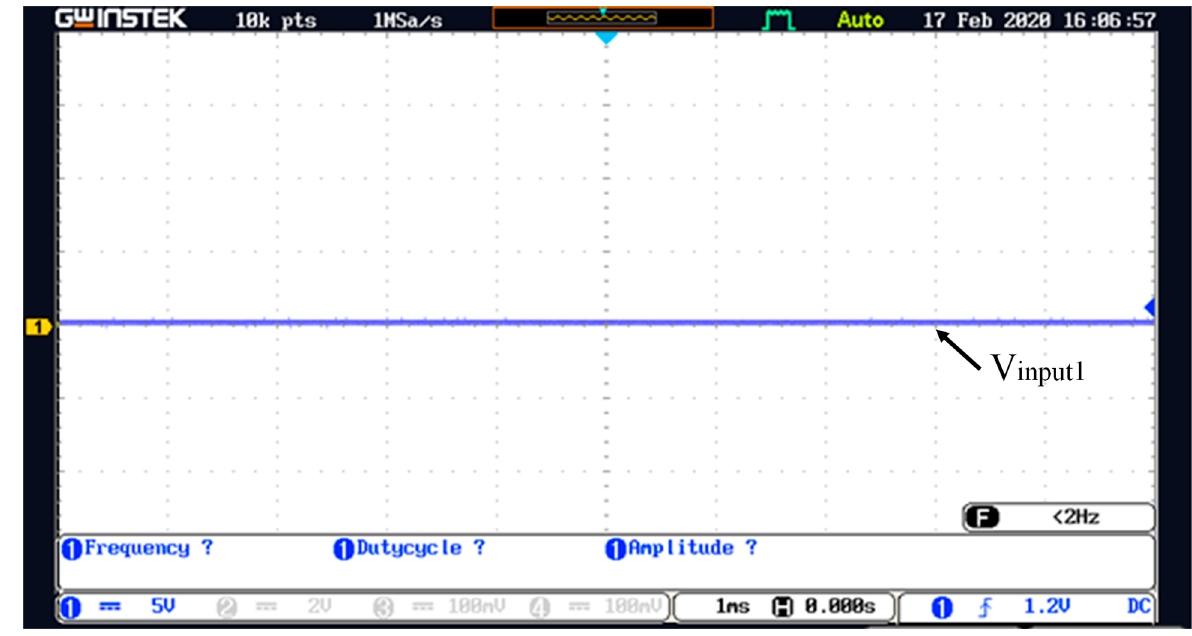
Figure 11. Experimental setup.